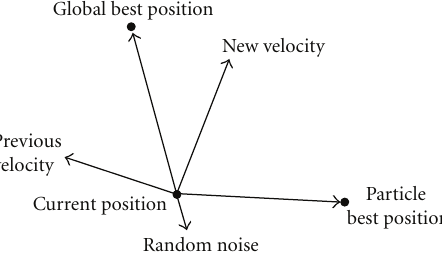
Figure 2: Influences on a